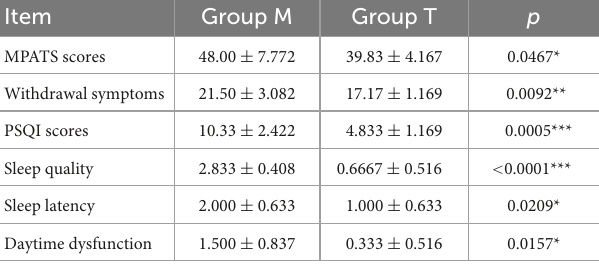
TABLE 2 MPATS and PSQI scores before and after acupuncture